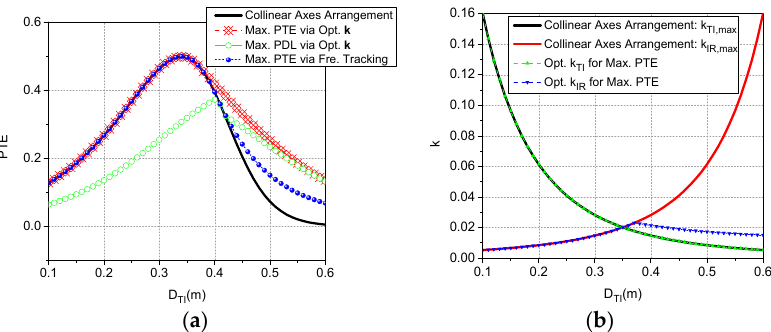
Figure 6. ( a ) Comparison between maximizing PTE goal by optimizing coupling coefficient vector, k , and three other power transfer scenarios; ( b ) Comparison between maximal coupling coefficient vector, [ k TI,max , k IR,max ], of collinear axes arrangement scenario and optimal coupling coefficient vector, [ k TI , k IR ], for maximizing PTE goal.